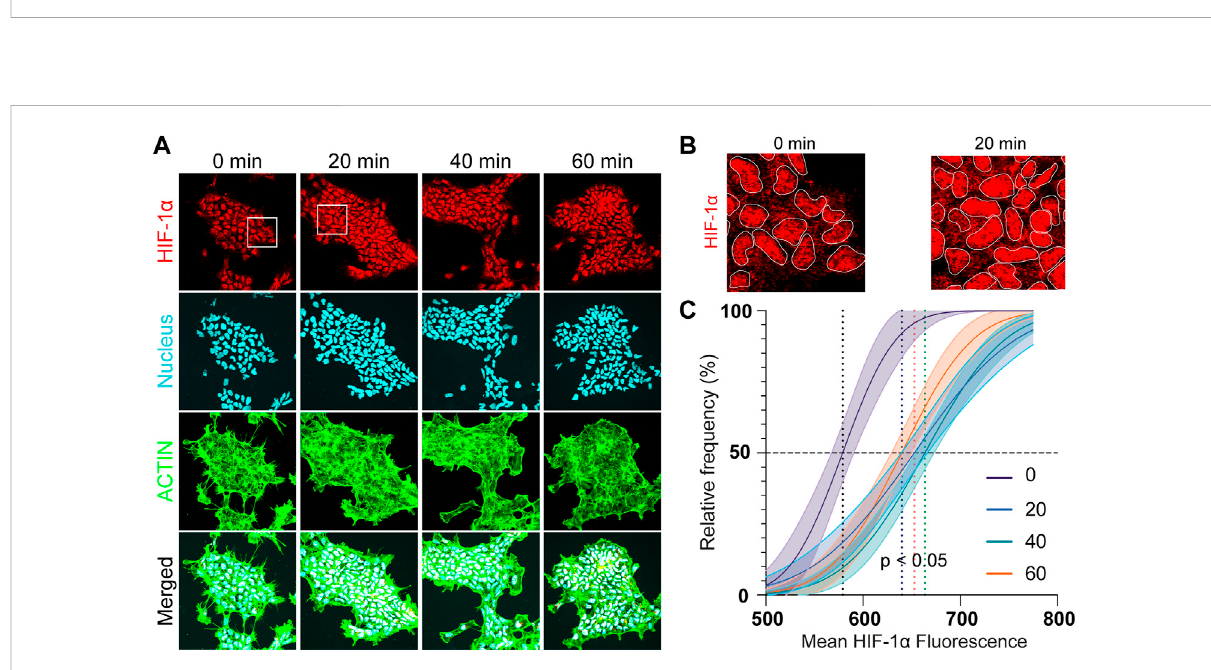
FIGURE 6 Acutehypoxia ofhNPCs. (A) Representative confocalimages of hNPCs inacute hypoxia: HIF-1 α (red); nucleus (cyan); actin (green). (B) Zoom in oftheconfocalimagesforcomparison. (C) FrequencydistributionanalysisofthemeanHIF-1 α intensityinthecellsunderdifferenthypoxiadurations.